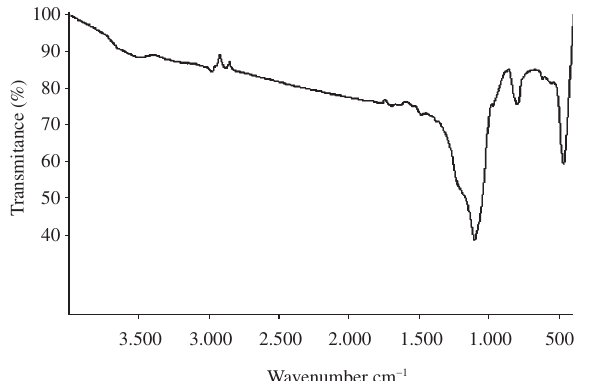
Figure 4. Fourier transform Infrared spectroscopic analysis of the as-synthe- sized sample prepared from Tween 80 and Span 80 surfactant mixture, in the